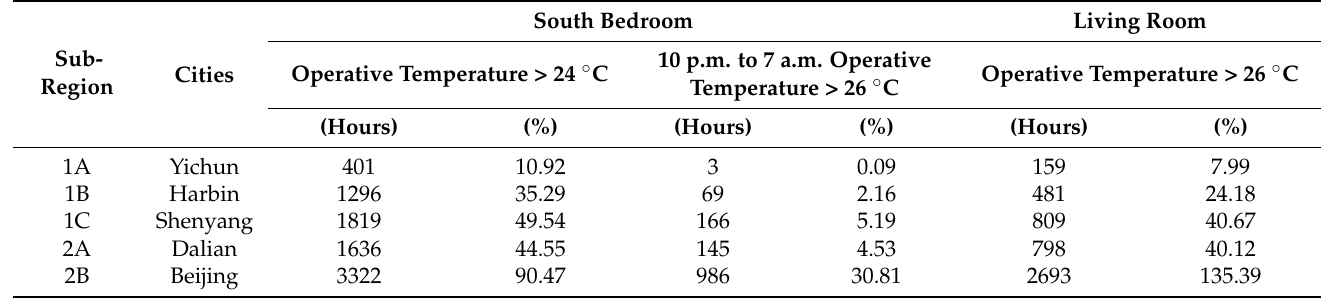
Table 10. South bedroom and living room overheating assessment based on CIBSE TM59.